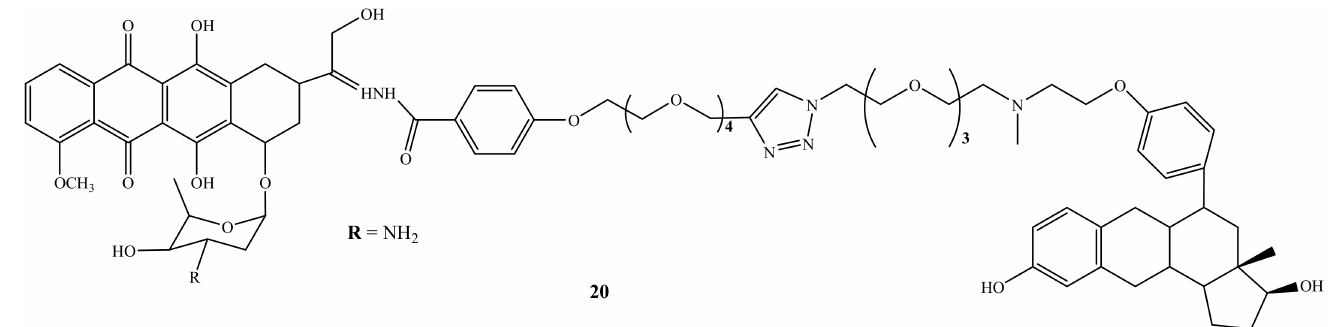
Figure 16. Chemical structure of steroidal anti-estrogen − doxorubicin bioconjugate ( 20